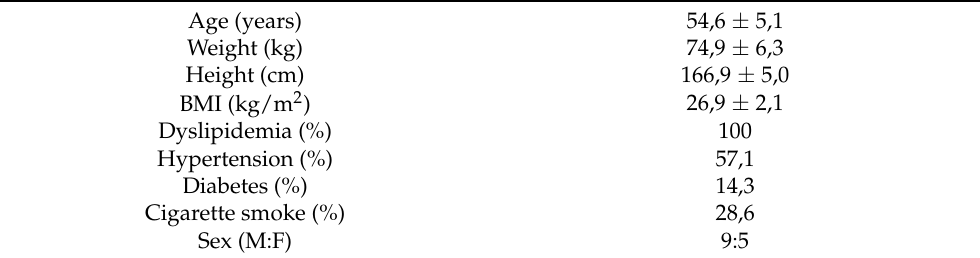
Table 1. The table shows the clinical characteristics and cardiovascular risk factors (%) of the 14 patients